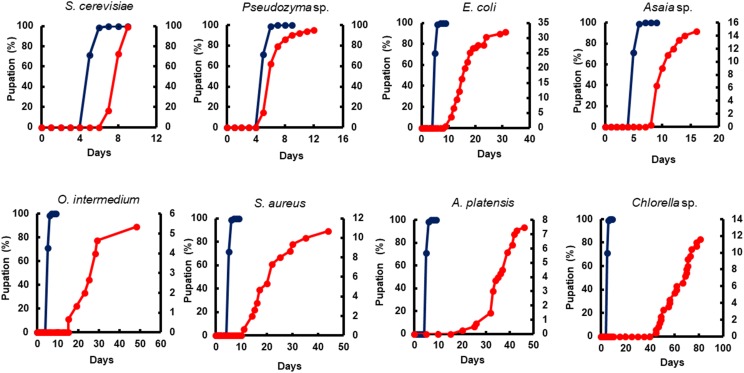
The impact of microorganism-based diets on pupation time. A representative pupation curve is comparing larvae fed with Tetramin (Dark blue line, left y-axis) and larvae fed with microbial cells (red line, right y-axis). The dietary supply was administered only at L1. Dead individuals were removed daily.